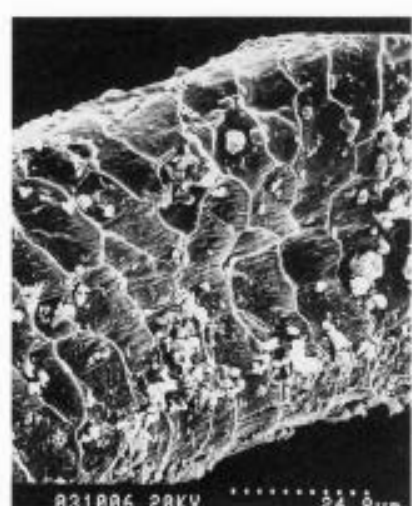
Figure 5 Scanning electron micrograph of hair, probably from a goat, found in a pottery vessel in the deposit in the side